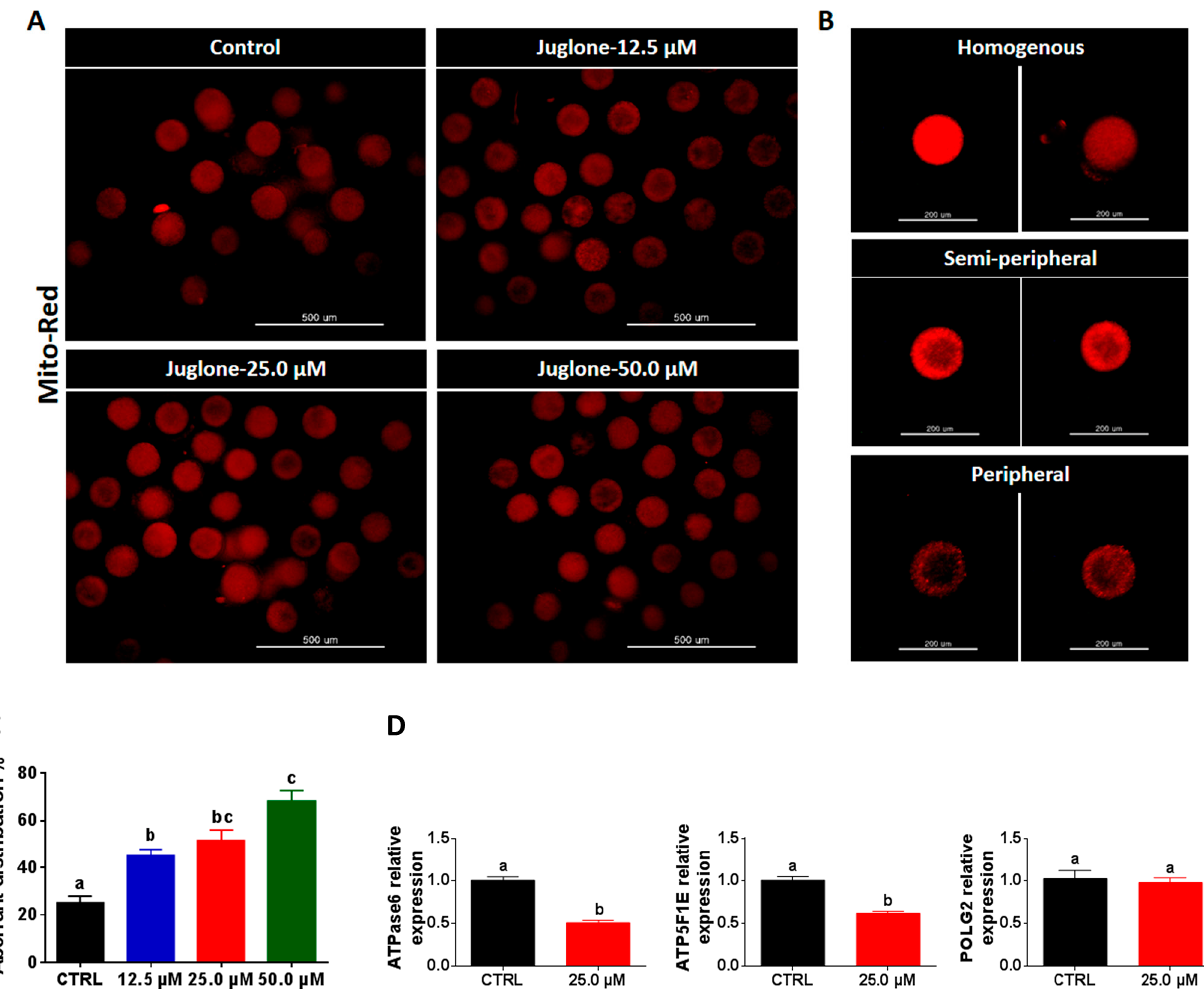
Figure 5. Mitochondrial distribution pattern after juglone administration. ( A ) Mito-Tracker Red labeling of mitochondria in juglone-treated and the control oocytes. Scale bar = 500 µm. ( B ) Representative images for the homogeneous and aberrant (semi-peripheral and peripheral) distribution patterns of mitochondria. Scale bar = 200 µm. ( C ) Percentage of oocytes with an aberrant pattern. ( D ) The relative expression of the mitochondrial genes ATPase6, ATP5F1E, and POLG2 tested using RT–qPCR. Mito-Red: Mito-Tracker Red. The different letters on the columns reflect statistical significance ( p < 0.05).